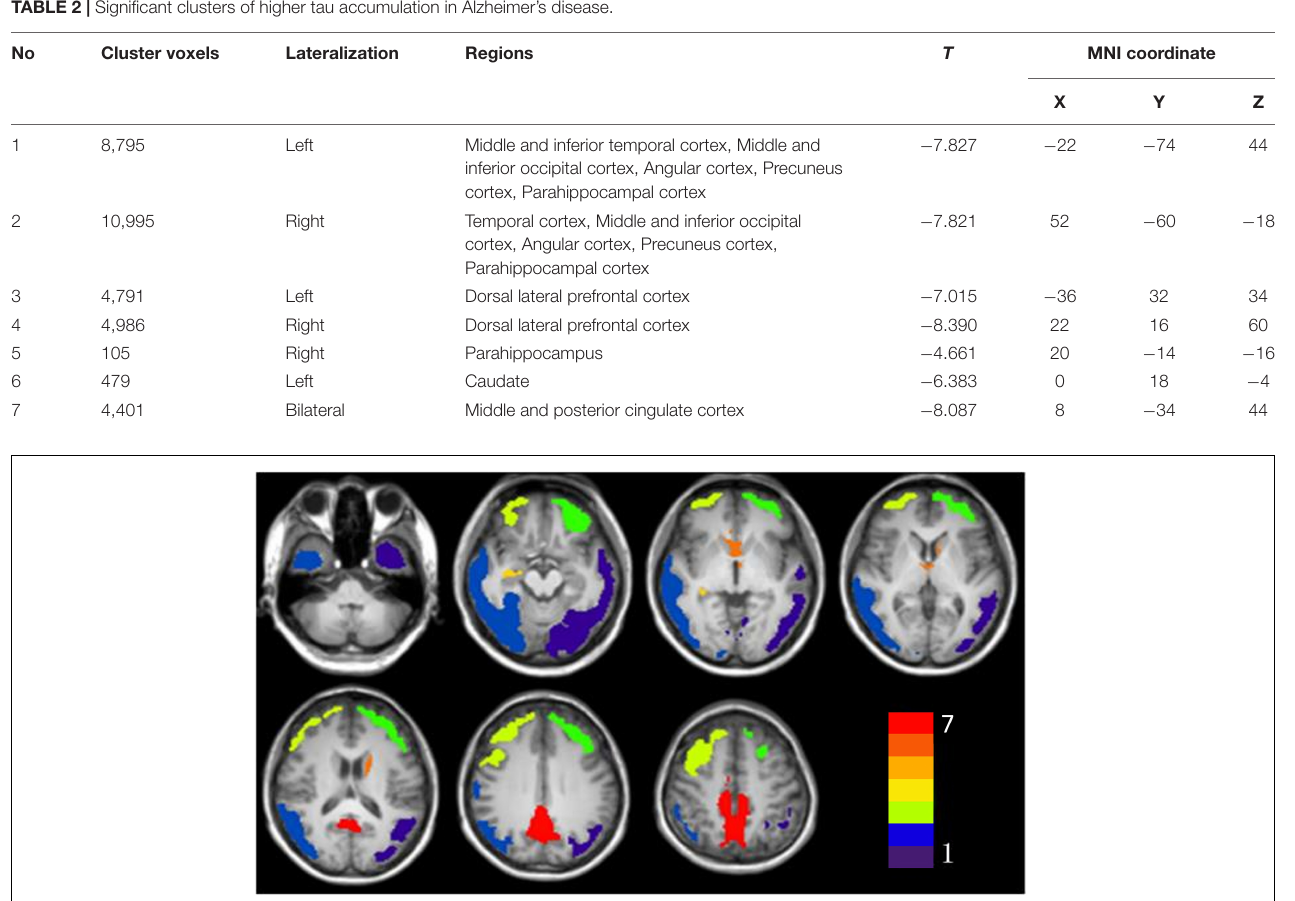
TABLE 2 | Significant clusters of higher tau accumulation in Alzheimer’s disease.